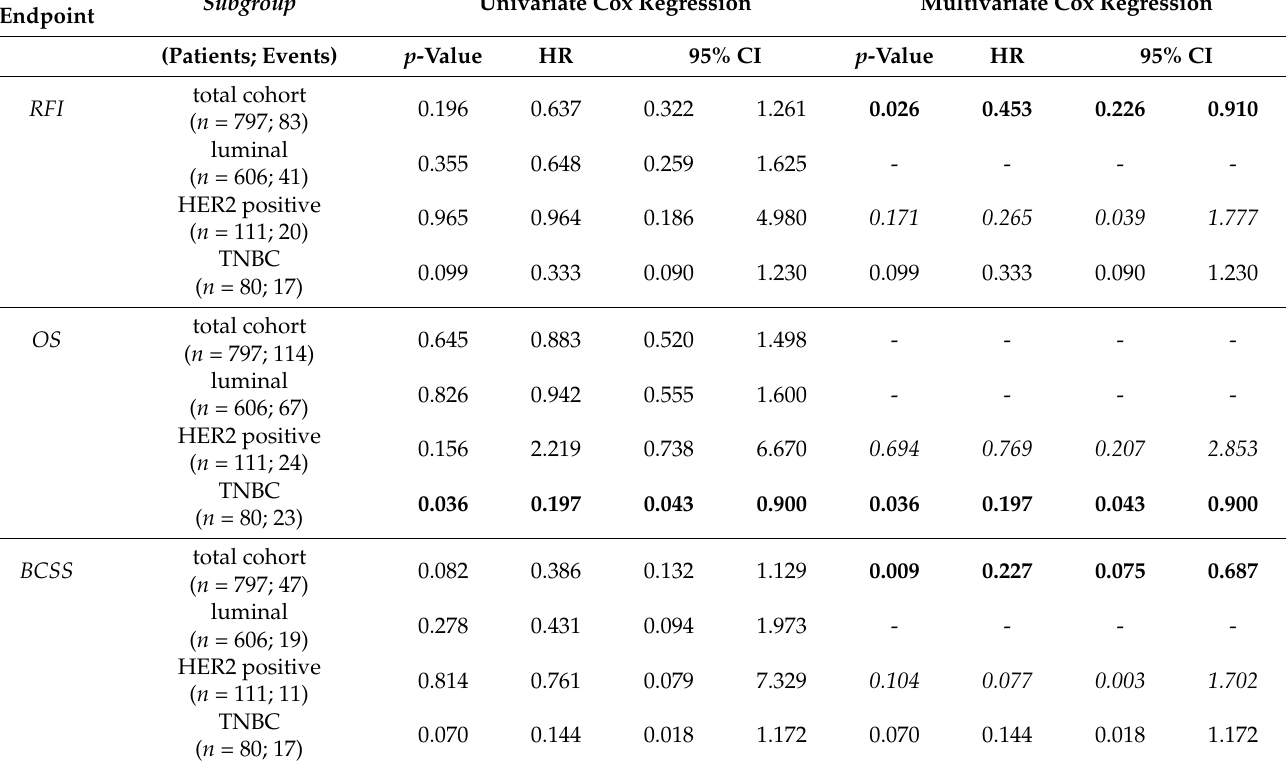
Table 2. Prognostic impact of the FTNB-609 promoter polymorphism rs11623866 (G > C) for genotype C/C vs. G/G in univariate und multivariate analyses of RFI, OS, and